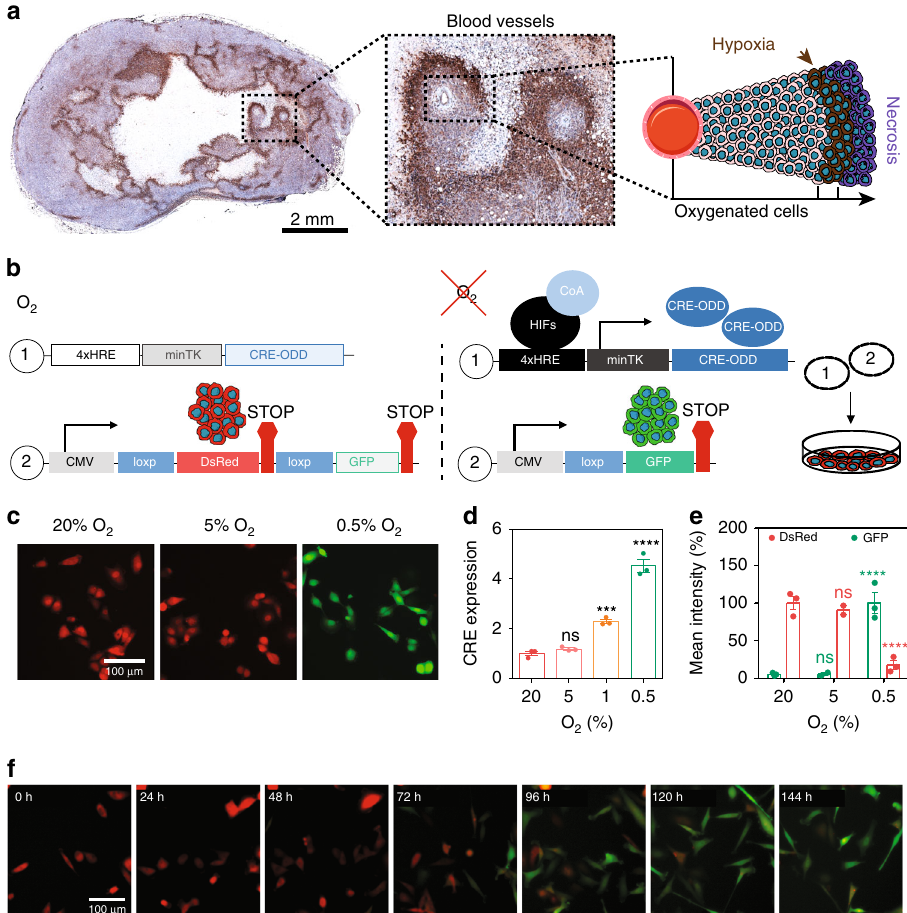
Fig. 1 Establishing a hypoxia fate-mapping system. a A full cross section of a mouse mammary tumor stained with Hypoxyprobe ™ (brown). The inset shows cancer cells surrounding two blood vessels. The cartoon depicts the spatial distribution of hypoxic cells (brown) adjacent to necrotic cells (purple) and oxygenated cells (pink). b Two lentiviral vectors used to generate a hypoxia fate-mapping system. c Fluorescent images of MDA-MB-231 hypoxia fate- mapping cells following exposure to 20%, 5%, or 0.5% O 2 for 7 days. Scale bar: 100 μ m. d Relative expression of CRE mRNA levels measured by qPCR in hypoxia fate-mapping MDA-MB-231 cells exposed to 20%, 5%, 1%, or 0.5% O 2 (mean ± SEM, N = 1, n = 3); **** P < 0.0001 versus 20% (one-way ANOVA with Bonferroni posttest). e Normalized quanti fi cation of fl ow cytometry analysis of MDA-MB-231 hypoxia fate-mapping cells following exposure to 20%, 5%, or 0.5% O 2 for 7 days (mean ± SEM, N = 2 – 3, n > 10,000 for 20%, 5%, and 0.5% O 2 ); **** P < 0.0001 versus 20% DsRed or GFP (Two-way ANOVA with Bonferroni posttest). f Fluorescent live-cell time-lapse imaging of MDA-MB-231 hypoxia fate-mapping cells cultured under 0.5% O 2 imaged over a